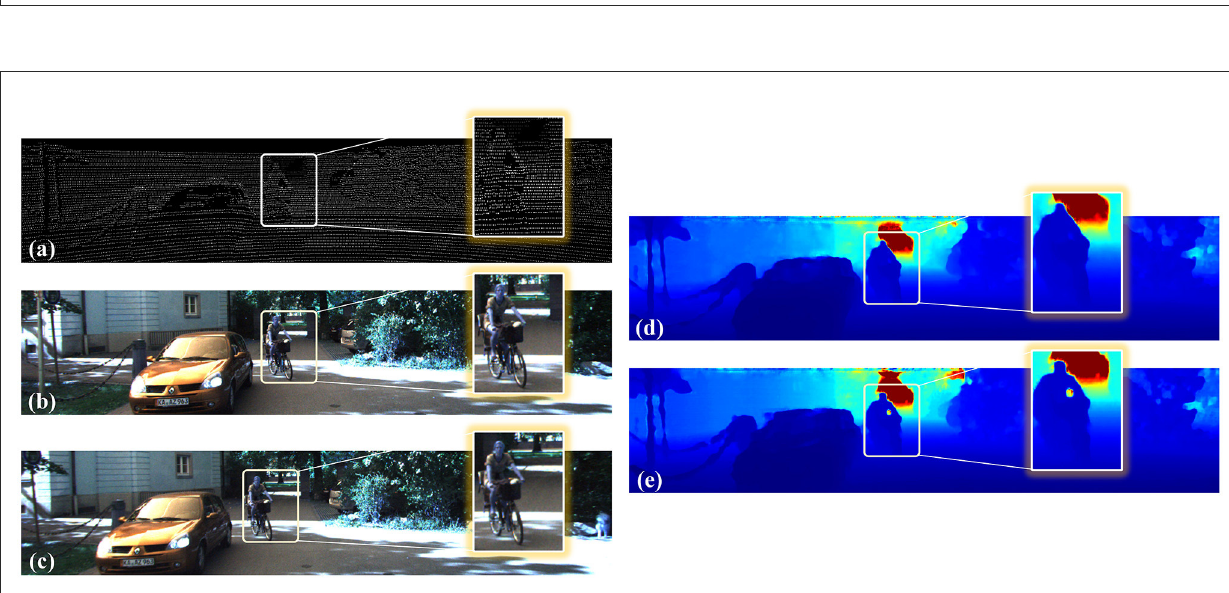
FIGURE8 The effects of the injected guided updating module. (a) is the sparse point cloud. (b, c) are the left and right image pairs. (d) is the result before adding the module, and (e) is the result after adding the